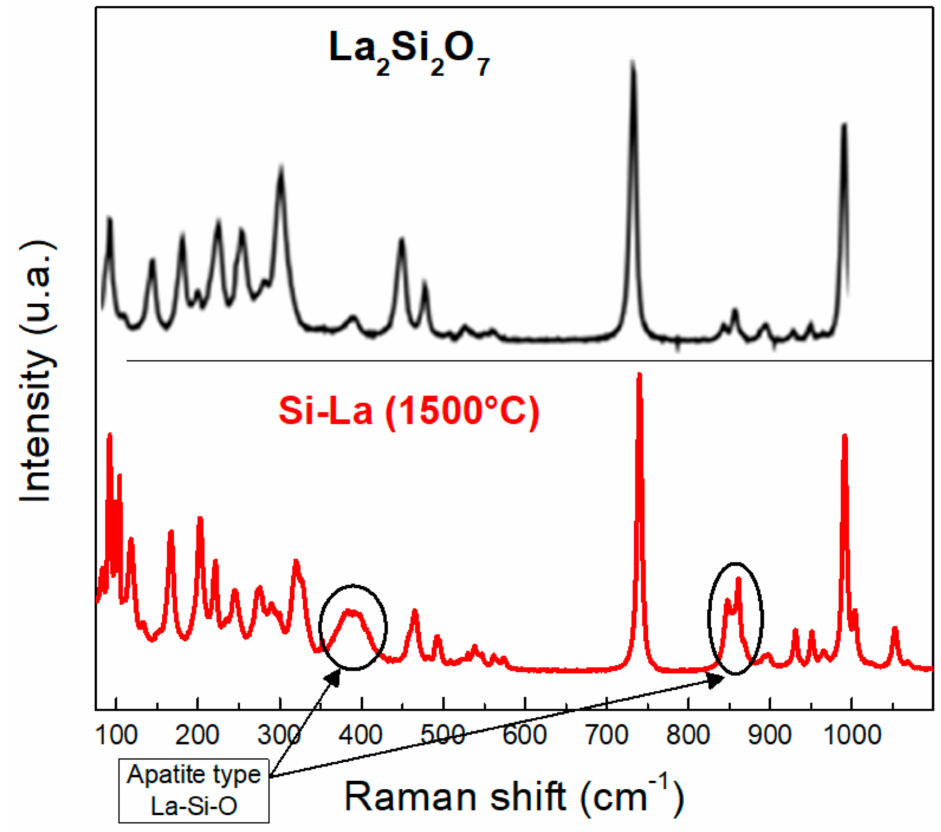
Figure 10. Raman spectra of Si-La after thermal treatment and La 2 Si 2 O 7 [32]. Adapted with permis- sion from Ref. [32]. Copyright 2022, American Chemical Society.